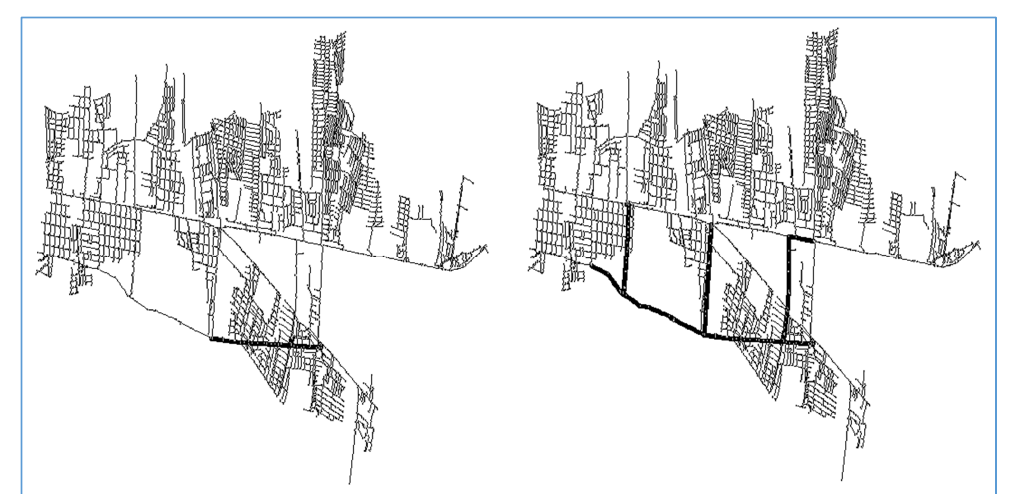
Figure 3. Trunk network definition.